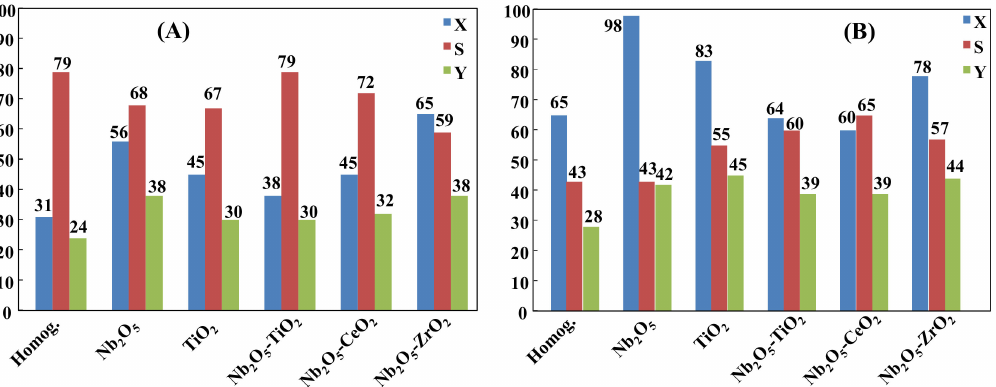
Figure 8. Fructose conversion ( X ), selectivity to HMF ( S ) and yield ( Y ) obtained in the experiments carried out with an initial fructose concentration of 0.3 M ( A ) and of 1.0 M ( B ) at 165 ◦ C for 3 h in the presence of 6 mL of the reaction mixture containing an amount of solid, in the heterogeneous catalytic experiments, of 2 g · L − 1